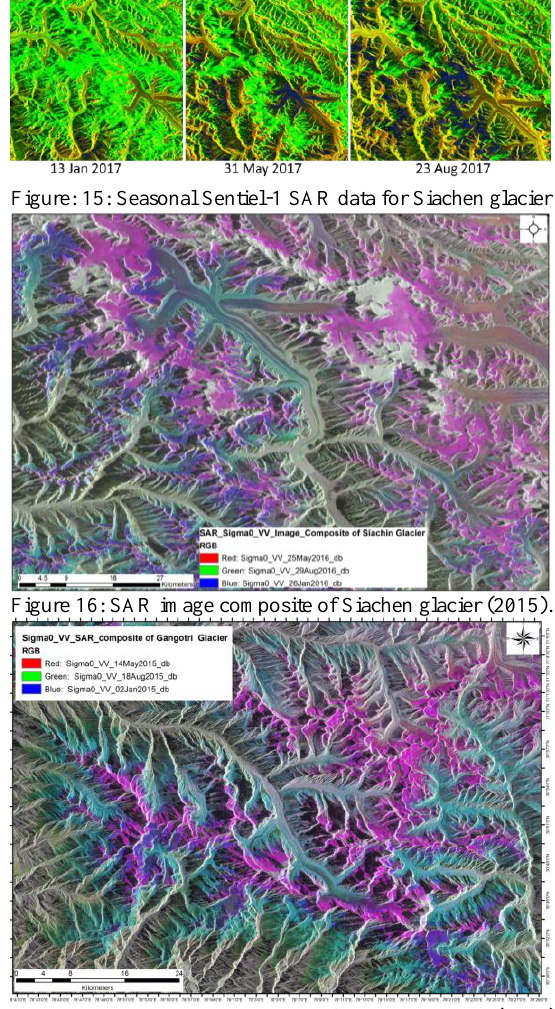
Figure 17: SAR image composite of Gangotri glacier (2015).